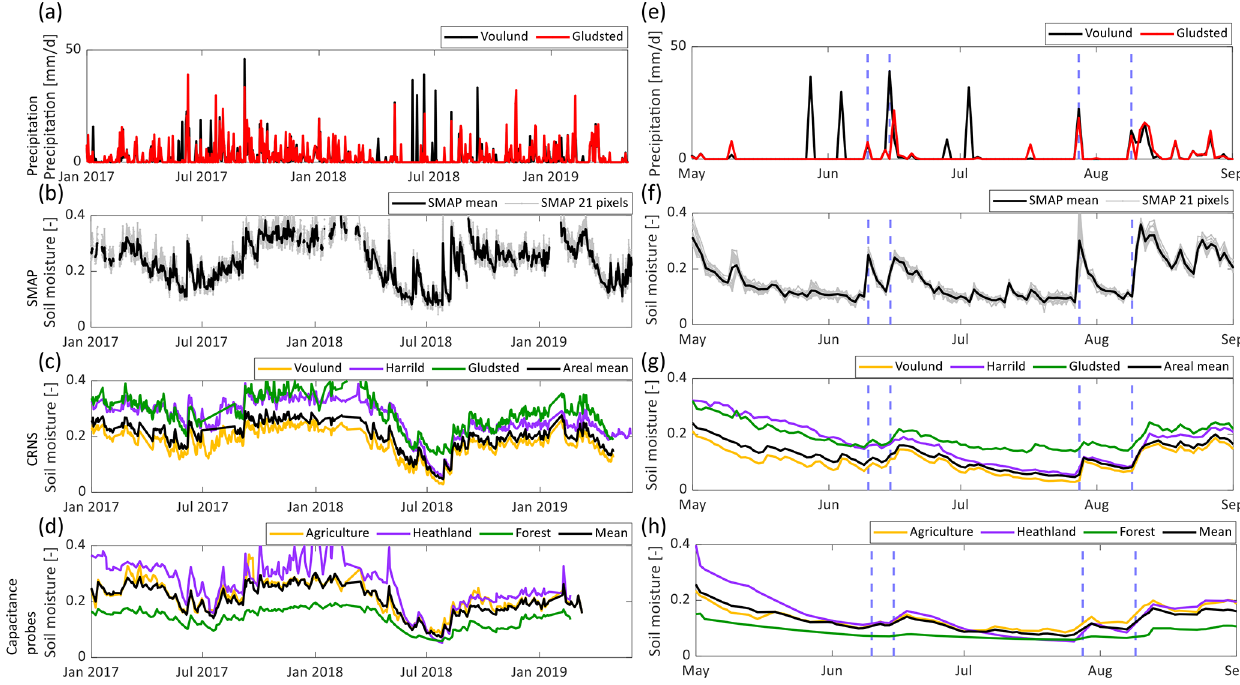
Figure 2. (a) Precipitation at two field sites: Voulund (agriculture) and Gludsted (forest). Differences in peaks relate to irrigation at the agricultural site (source of precipitation data: DMI.dk, 2021, open data). (b) Time series of daily soil moisture estimates by SMAP for all 21 pixels and averaged over the whole area. (c) Time series of CRNS-derived daily soil moisture at the three field sites: Voulund (agriculture), Harrild (heathland) and Gludsted (forest). (d) Time series of daily soil moisture (depth of 0–5cm) derived by capacitance probes and representing the mean of the three LUC. Panels (a–d) show the time series for the entire 2.5-year study period while panels (e–h) show the growing period May–September in